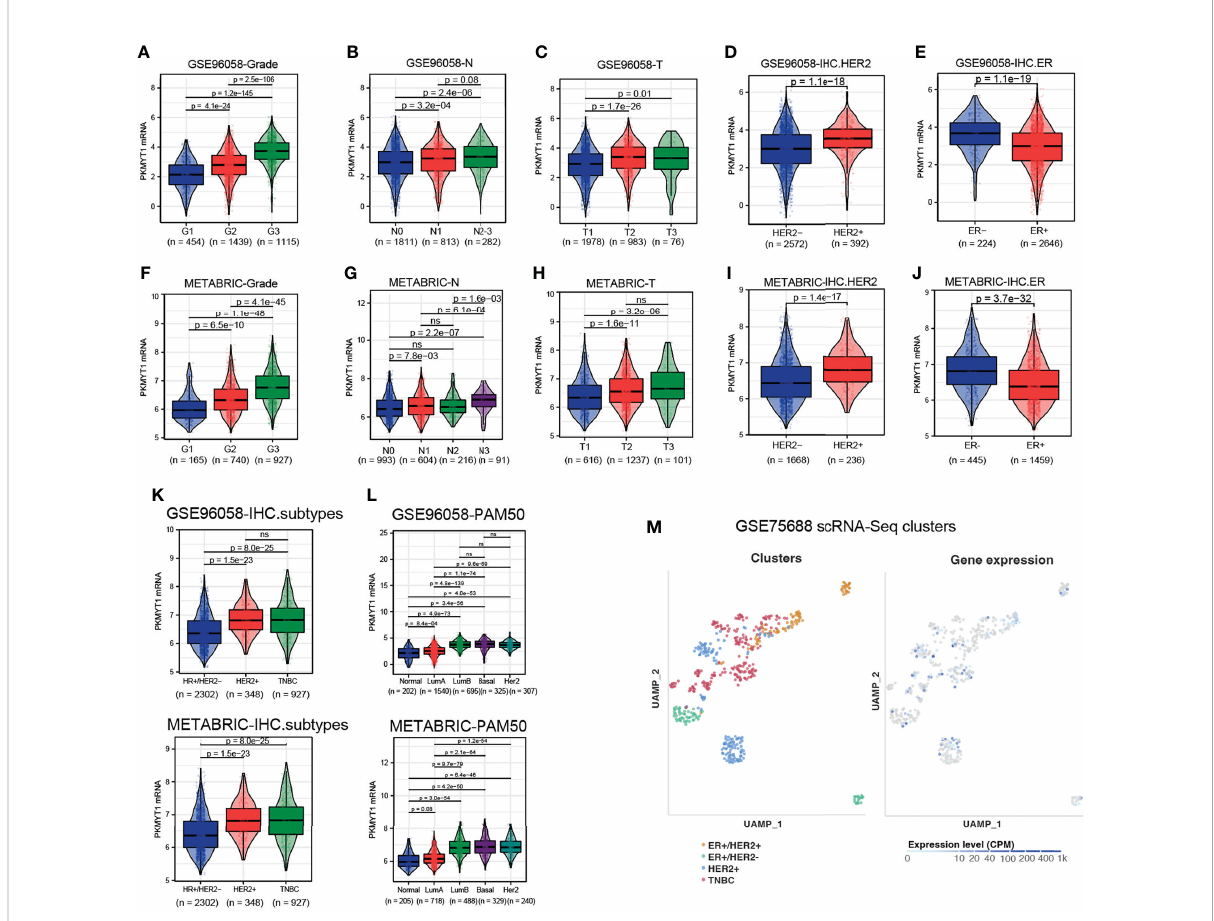
FIGURE 2 The correlation between PKMYT1 expression and clinicopathologic features in BC was analyzed using multi-source datasets. (A – E) The PKMYT1 mRNA expression levels in different tumor grade, tumor size stage, lymph node metastasis stage, HER2 status and ER status were analyzed in GSE96058 cohort. (F – J) The PKMYT1 mRNA expression levels in different tumor grade, tumor size stage, lymph node metastasis stage, HER2 status and ER status were analyzed in METABRIC cohort. (K, L) The PKMYT1 mRNA expression levels in different immunohistochemical molecular type or PAM50 molecular type were analyzed in GSE96058 and METABRIC cohorts. (M) Single-cell sequencing data analysis of GSE75688 cohort for PKMYT1 expression in different molecular types of breast cancer. ns, no signi fi